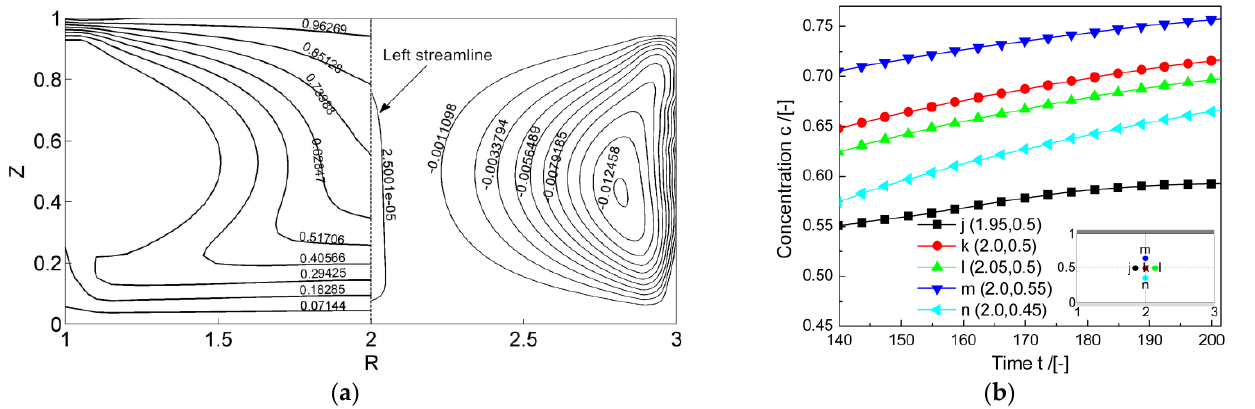
Figure 5. ( a ) Distributions of concentration and velocity fields at t = 150; ( b ) Concentration distribution at monitoring points in the center of liquid bridge ( Ca C = − 0.01, R = 2.5 mm, H/R = 1.0, Vr = 1.0). Figures 6 and 7 represent the oscillations of the radial and axial velocities at the moni- toring points in the high-concentration corner, respectively. On the whole, the law of radial velocity oscillation is relatively obvious, while the axial velocity oscillation is relatively disordered, showing certain pulsation characteristics. The radial velocity is greater than the axial velocity and the oscillation is more intense, and the oscillation of the velocity occurs prior to the oscillation of the concentration. As shown in Figure 6, the radial velocity begins to oscillate at t = 149 after a high-frequency disturbance, and the average oscillation period is T = 5. At t = 171, the oscillation period begins to decrease and the frequency increases, but the amplitude basically remains unchanged and begins to enter a stable high-frequency oscillation stage. In the horizontal direction, the velocity oscillation at point a is the most intense, and the oscillation is transmitted from the surface to the inside in terms of the amplitude and attenuation direction ( A a = 0.0028 ® A b = 0.002 ® A c = 0.0014). As shown in Figure 7, the axial velocity of each monitoring point presents certain pulsation characteristics after the disturbance, and the oscillation period and amplitude are small, indicating that the oscillation of the radial velocity is dominant at the corner. The transmis- sion direction of the axial velocity oscillation is the same as that of the radial velocity. The further away from the high-concentration corner, the more intense the oscillation in the vertical direction. The transmission direction of the fluctuation is from the bottom to the top ( A e = 0.0011 ® A b = 0.0008 ® A d = 0.0003). In general, the oscillation of the velocity is mainly affected by the variety of the solutocapillary convection on the surface and the motion of the cell flow structure on both sides, which will directly affect the redistribution and rebalance of the concentration with a long diffusion time. The oscillation of the con- centration lags behind that of the velocity eventually, which also shows that the oscillatory principle of the velocity and concentration is different.